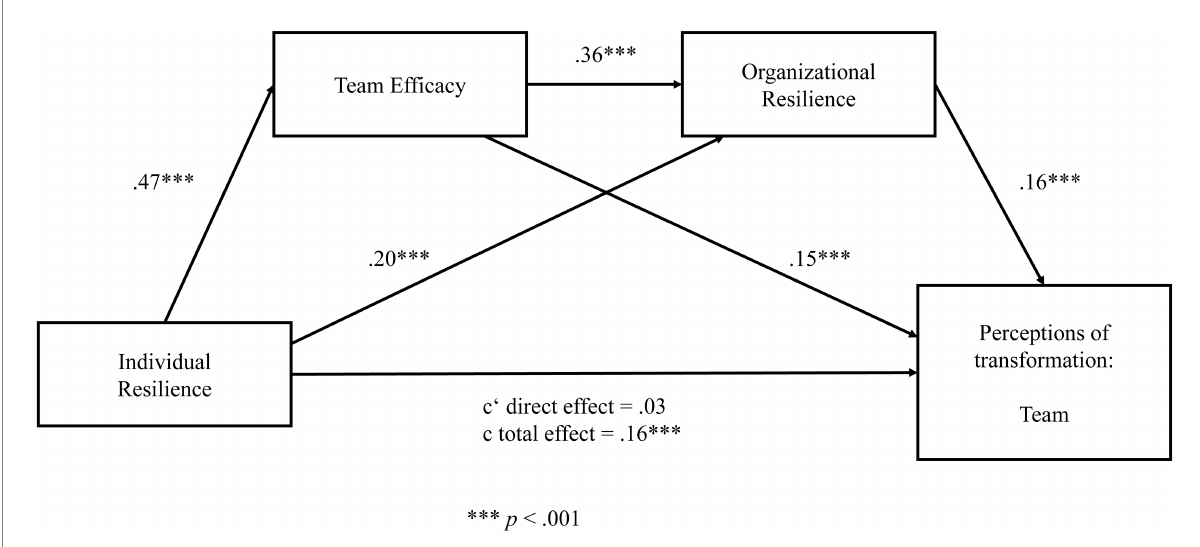
FIGURE 3 Sequential mediation model for perceptions of transformation on the team level. Significant at level *** p <